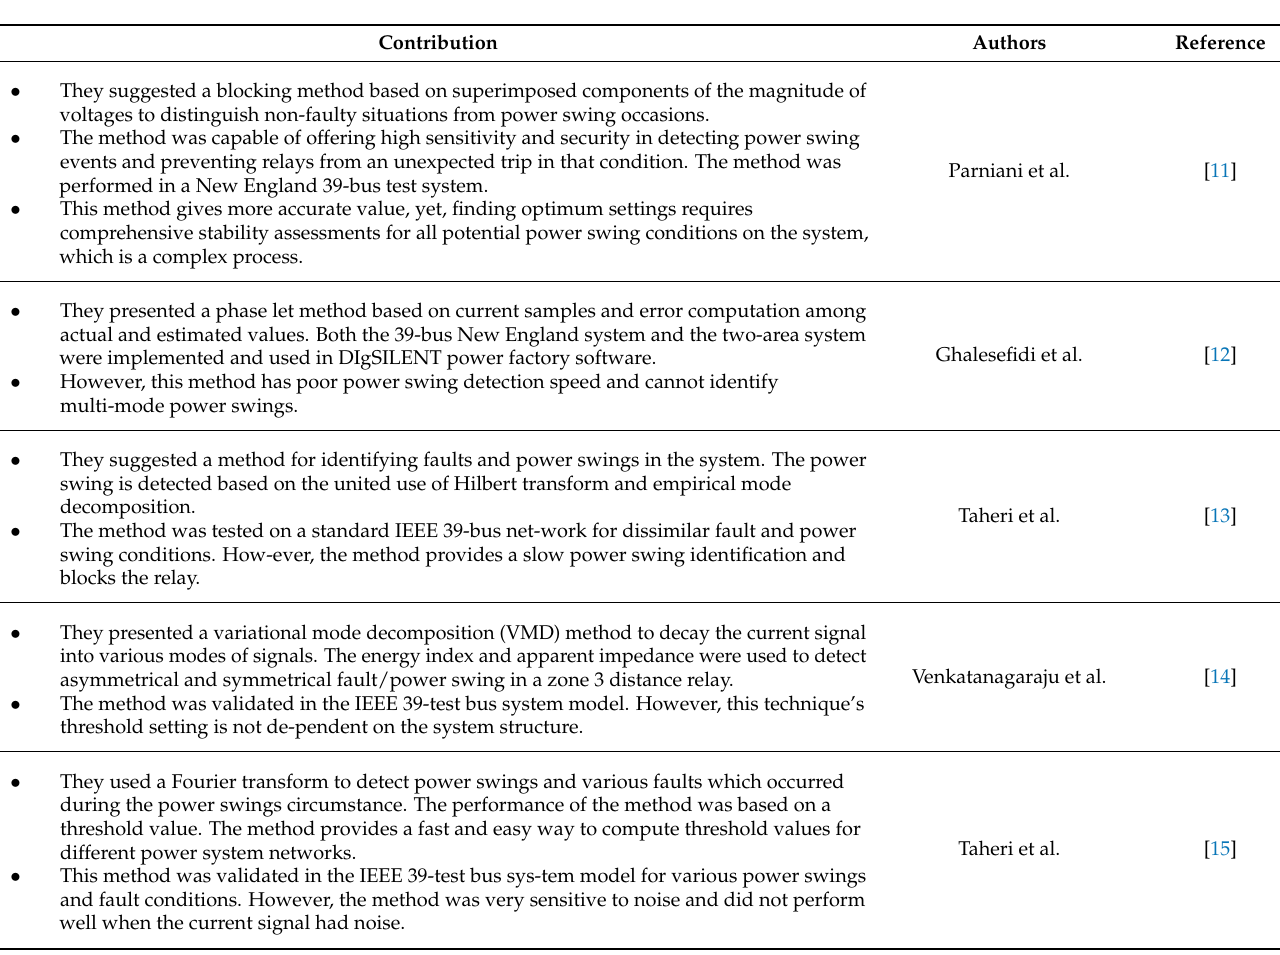
Table 1. Recent Works: A Brief